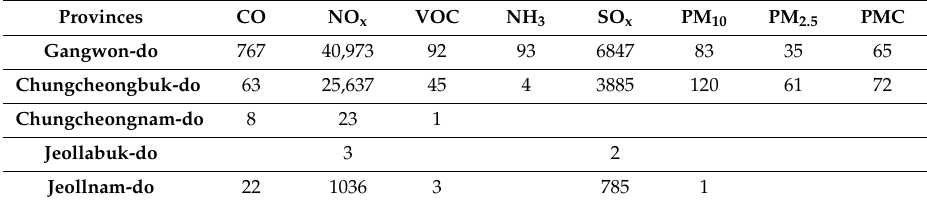
Table 3. Emissions from the cement industry in the CAPSS 2013 emissions inventory.